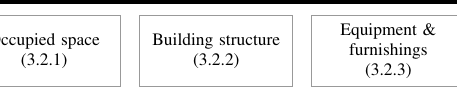
Figure 9. Levels of building structure